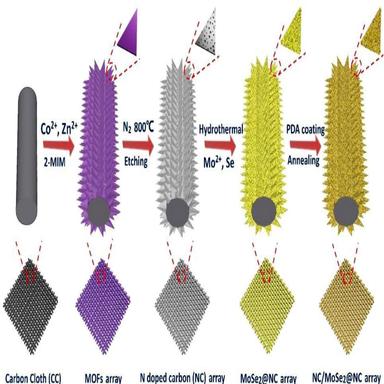
Schematic illustration for the preparation of sandwiched NC/MoSe2@NC core/shell array.